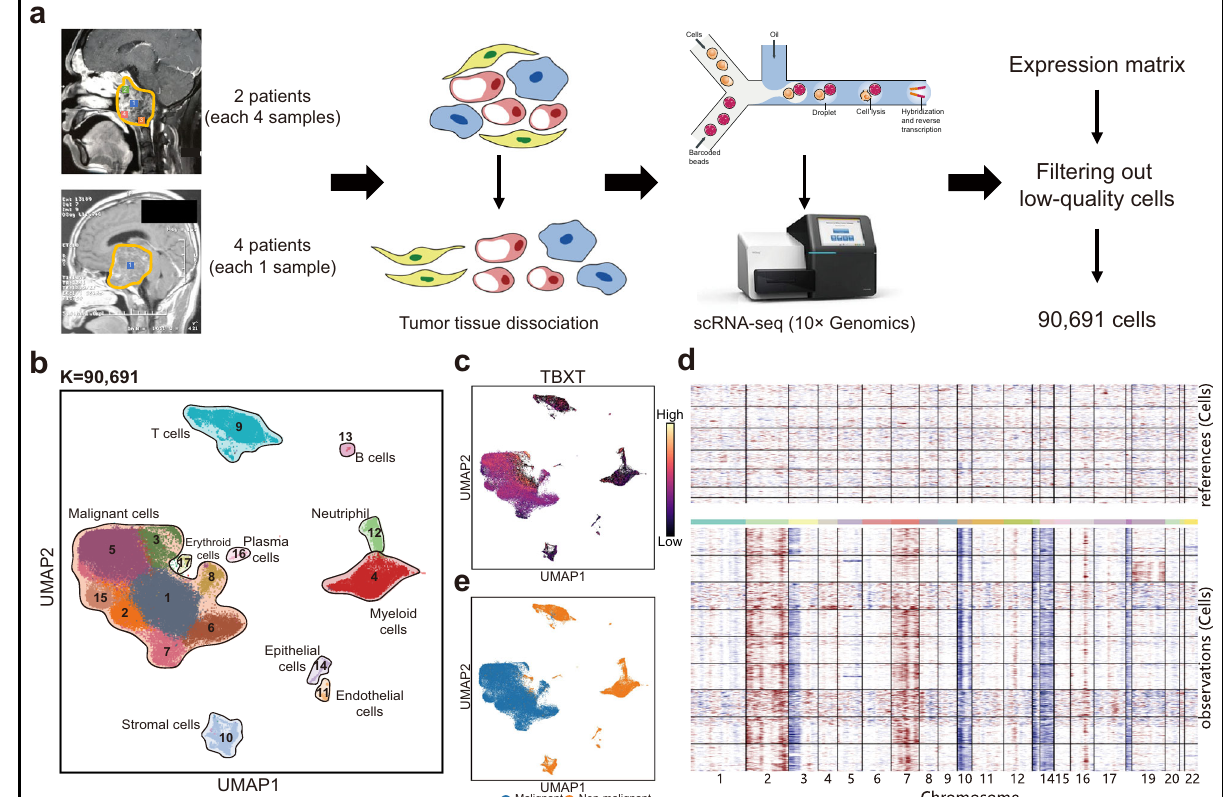
Fig. 1 Study design and identi fi cation of malignant cells by single-cell RNA-seq. a Work fl ow showed the collection and processing of fresh SBC samples for scRNA-seq. Four samples were obtained in the anterior, posterior, inferior and central regions of SBC from two patients, while one sample was obtained from each of the other four patients. b The UMAP of all 90,691 cells passed RNA QC from 12 samples of six patients. Cells were clustered into 17 clusters (marked by numbers). The 17 clusters were classi fi ed into 10 subtypes (marked by the text in black), including one malignant and nine nonmalignant groups according to canonical gene markers. c UMAP plot of TBXT , a known marker gene for SBC malignant cells. d Heatmap showed large-scale CNVs for individual cells (rows) from a representative tumor (Patient 1), inferred based on the average expression of 100 genes surrounding each chromosomal position (columns). Red: ampli fi cations; blue: deletions. e UMAP plot shows the distributions of malignant and nonmalignant cells based on CNVs and malignant cell